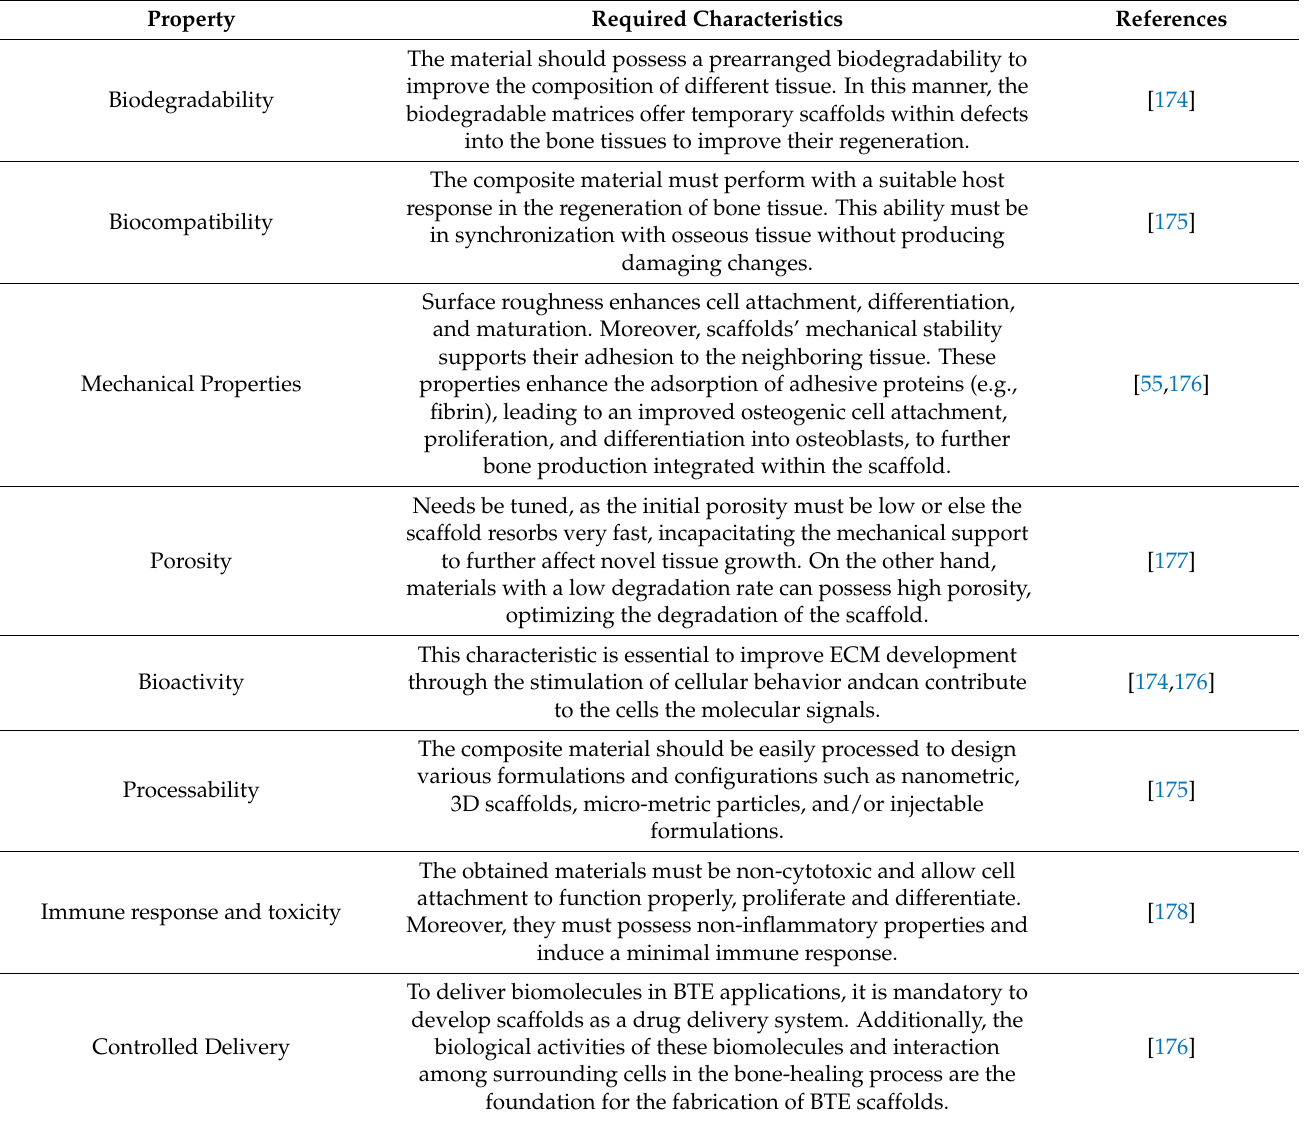
Table 4. Required properties of scaffolds in BTE